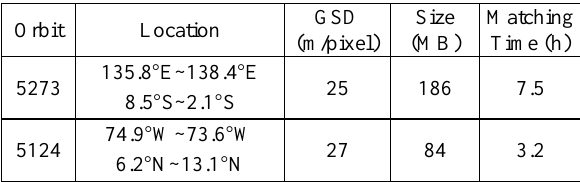
Table 1. Information of test